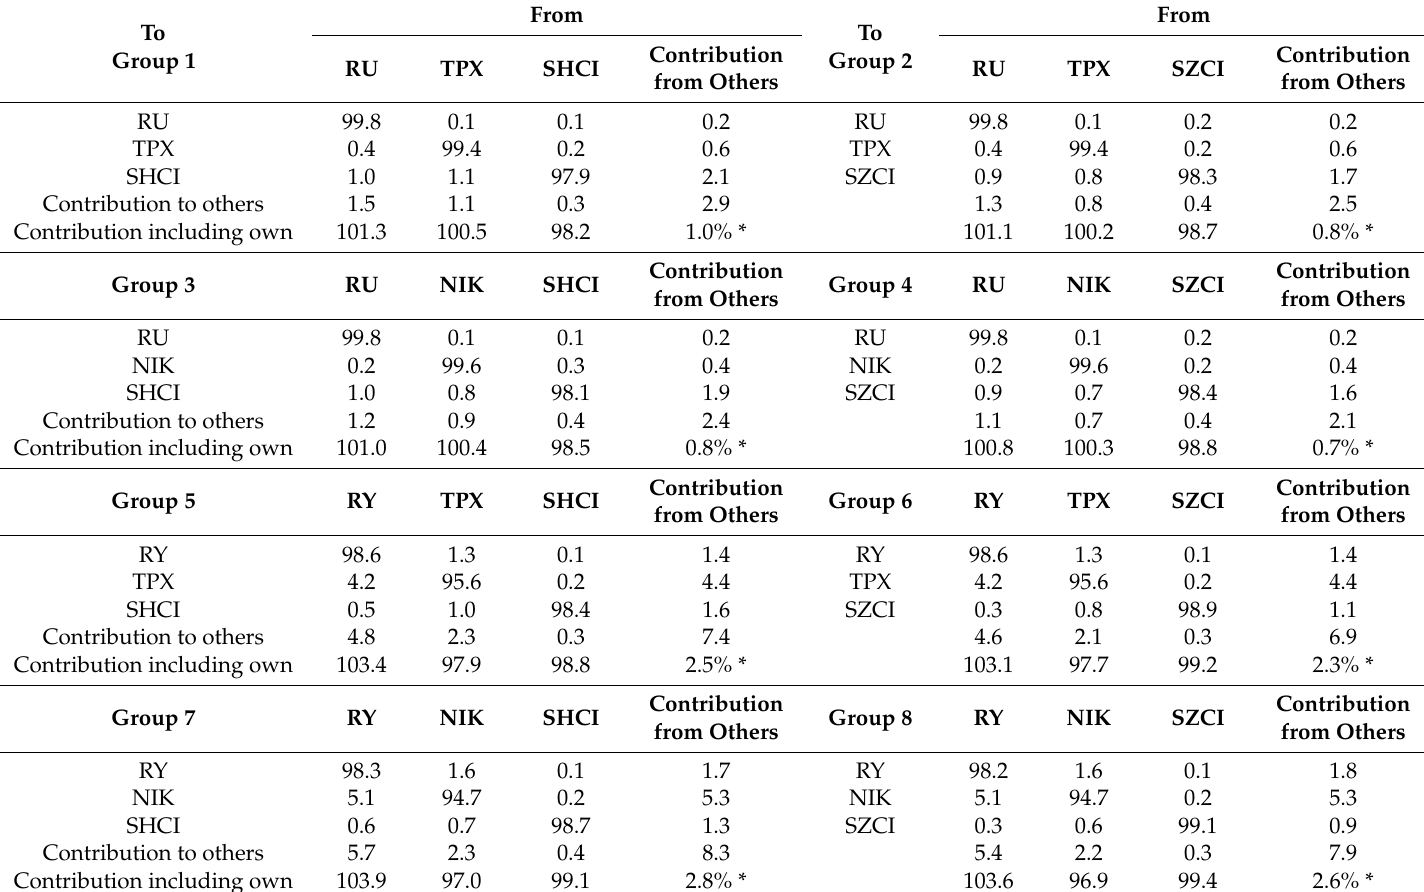
Table 9. Spillover Table on volatility by